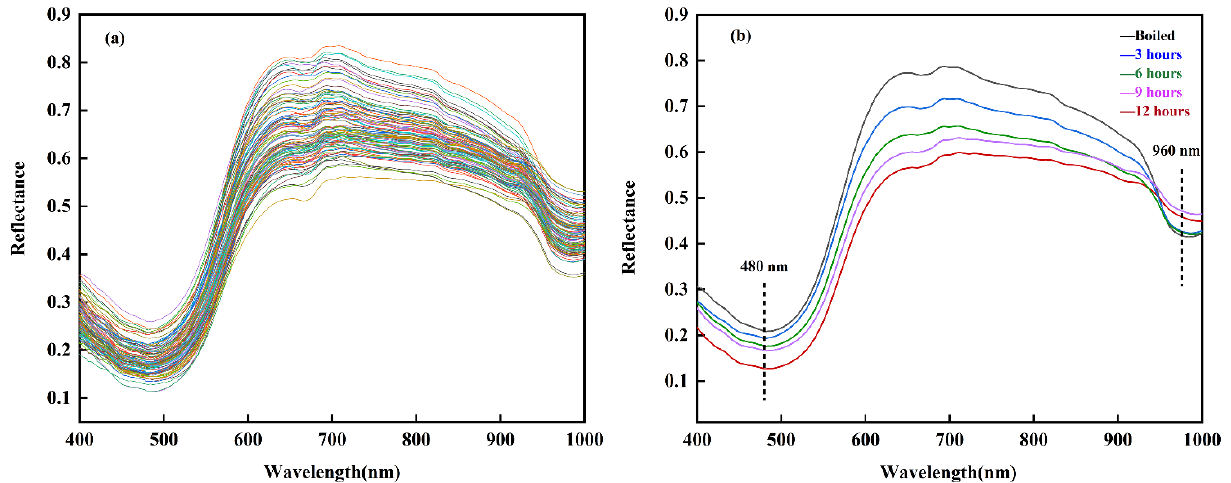
Figure 6. ( a ) Mean reflectance spectra of the ROIs in shrimp samples with different drying levels and ( b ) reflectance spectra at different drying times (boiled, 3, 6, 9, and 12 h).